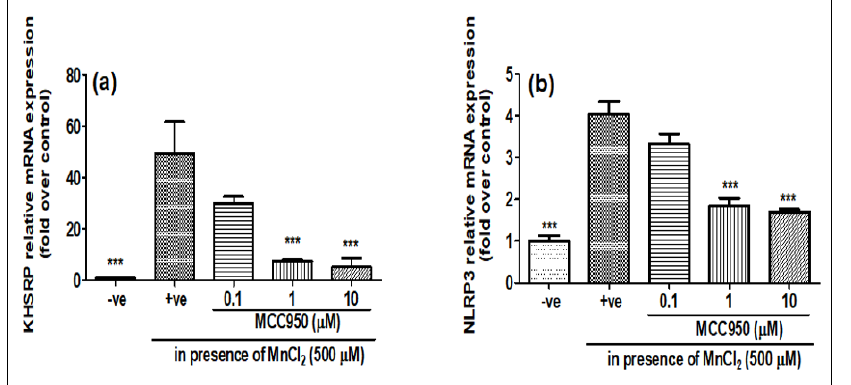
Figure 4. MCC950 inhibited MnCl 2 -induced KHSRP and NLRP3 genes gradually in a dose-dependent manner. N2a cells were pre-treated for 1 h with MCC950 (0.1, 1 and 10 µM) and later exposed to MnCl 2 (500 µM) for 24 h. ( a ) relative KHSRP mRNA expression; ( b ) relative NLRP3 mRNA expression. All mRNA values were normalized to the housekeeping mRNA, GAPDH, and expressed as a fold-induction over the control sample (set at a value of 1). Data represented as mean ± SEM. *** p < 0.0001 vs. control group.